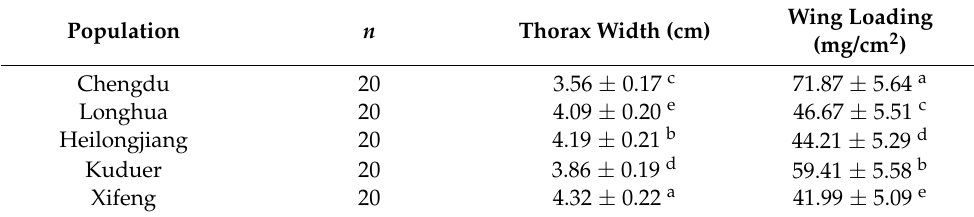
Table 6. Evaluation of body size between female Asian spongy moth ( L. dispar asiatica ) populations from five different geographical locations in China. Values are presented as Mean ±